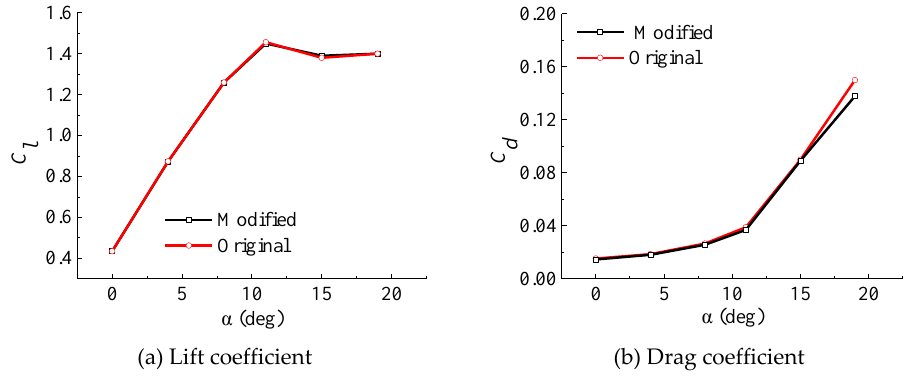
Figure 10. Aerodynamic performance comparison of the airfoil with and without the NLPS.